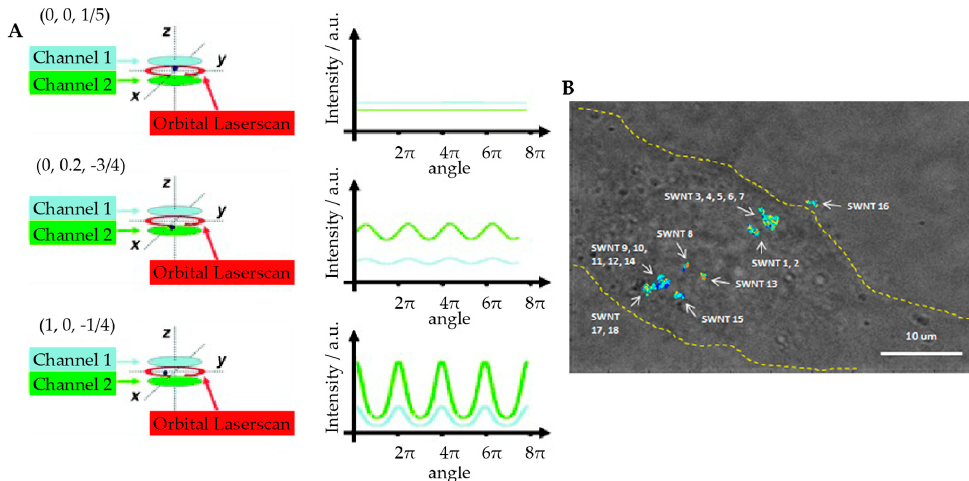
Figure 7. Orbital tracking with biplane detection. ( A ) Schematic of particle position measurement. The laser focus is scanned in a circle around the tracked particle while the two detection channels monitor the intensity at two axial planes (right panel). The X and Y positions of the particle are calculated from the modulation amplitude and phase of the fluorescence signal. The Z position is calculated by the di ff erence of the signal between the two detection channels. Reprinted from reference [84]. Copyright 2009 Wiley-VCH. ( B ) 3D orbital tracking of single-walled carbon nanotubes (SWNT) in live cells. The image shows overlaid bright field image of Hela cell (outlined in yellow) with 18 SWNT trajectories. Adapted from reference [85]. Copyright 2012 American Chemical